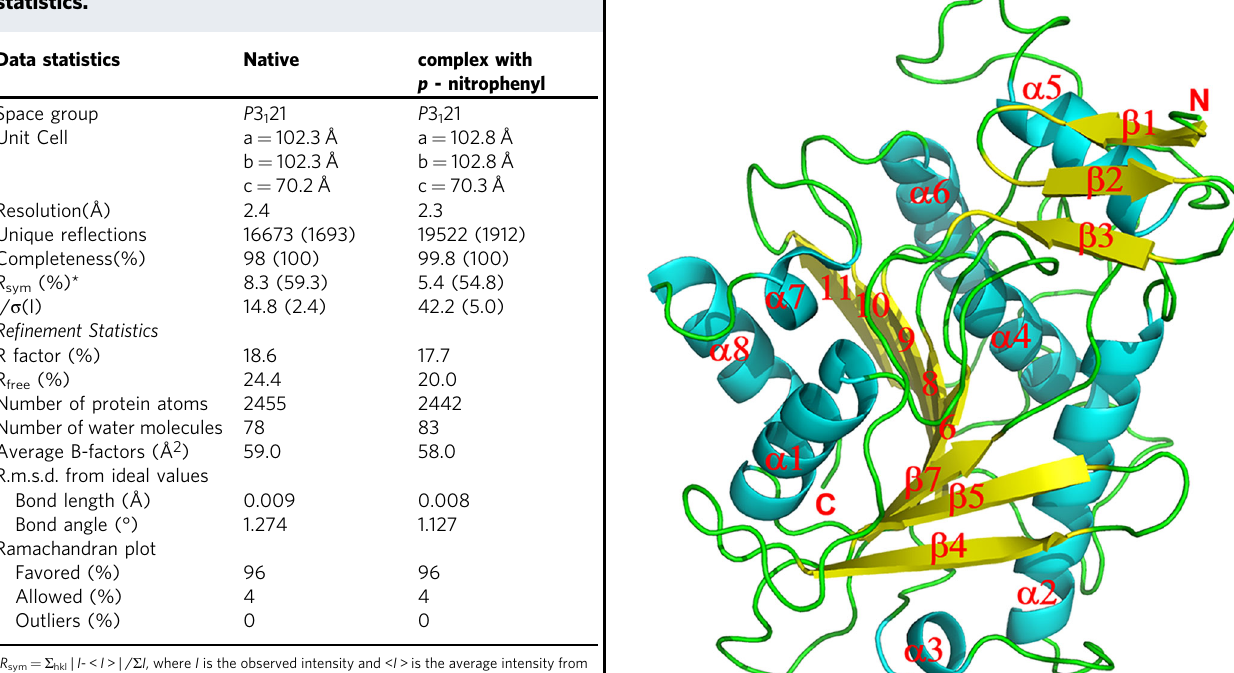
Table 2 Summary of 2-HID data collection and re fi nement statistics.